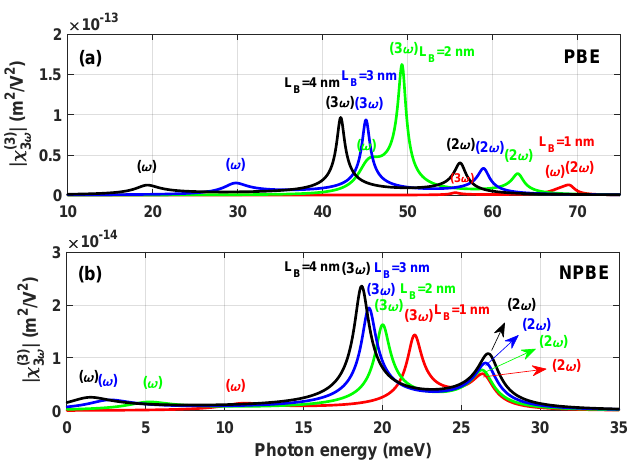
( 3 ) | versus the photon frequency ¯ h ω with 3 ω